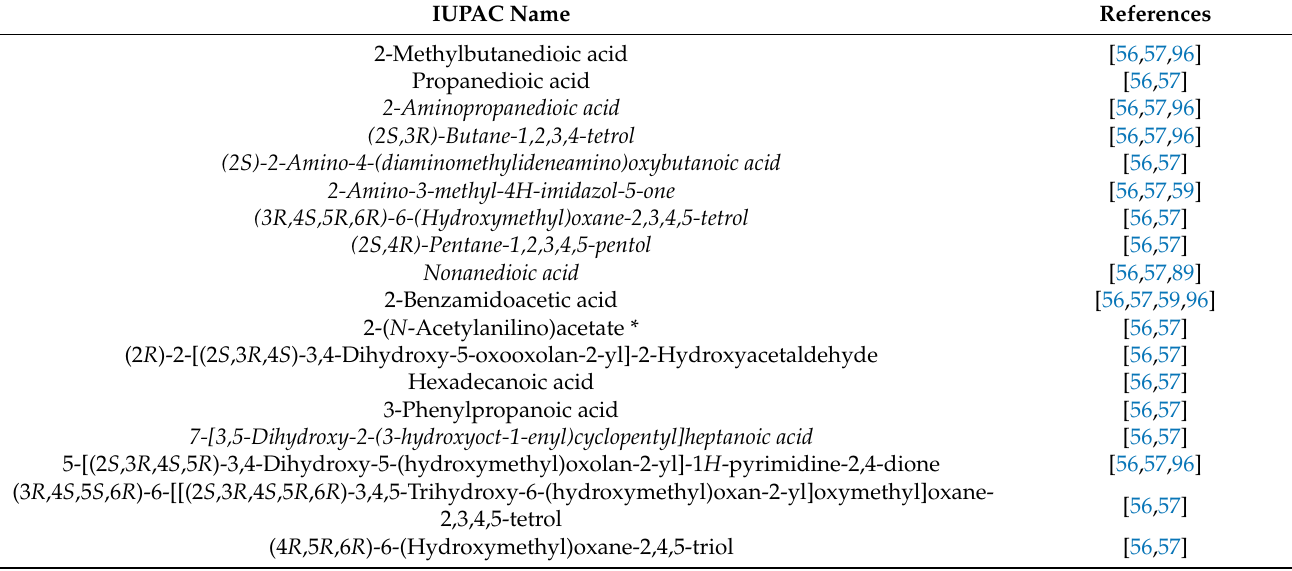
Table 3. List of major metabolites reported to be present in camel